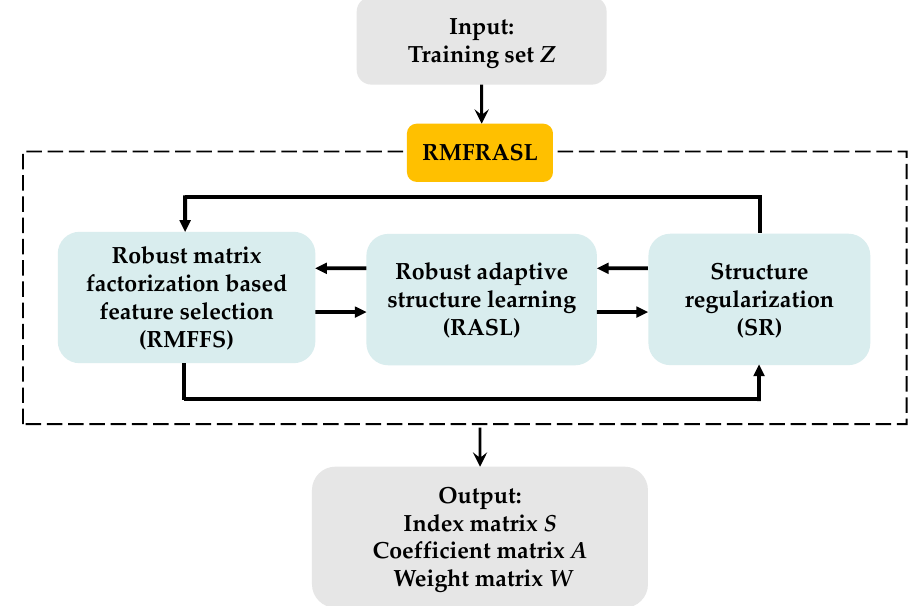
Figure 1. The structure flowchart of the proposed RMFRASL method.